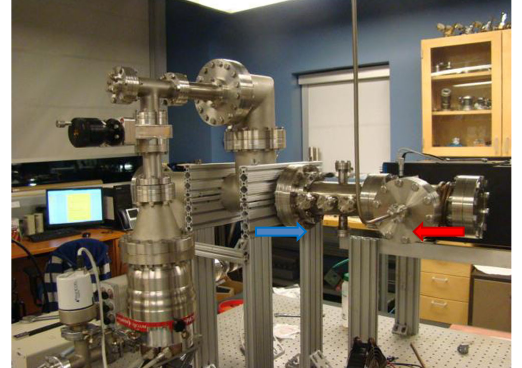
FIG. 4. Experimental setup for cylindrical plasma processing.